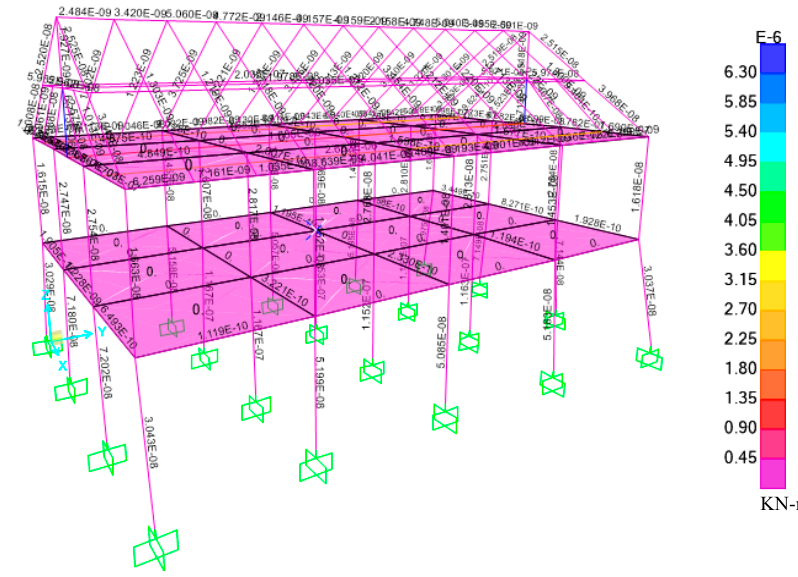
Figure 5. RVW (Relative virtual work) Output Model.